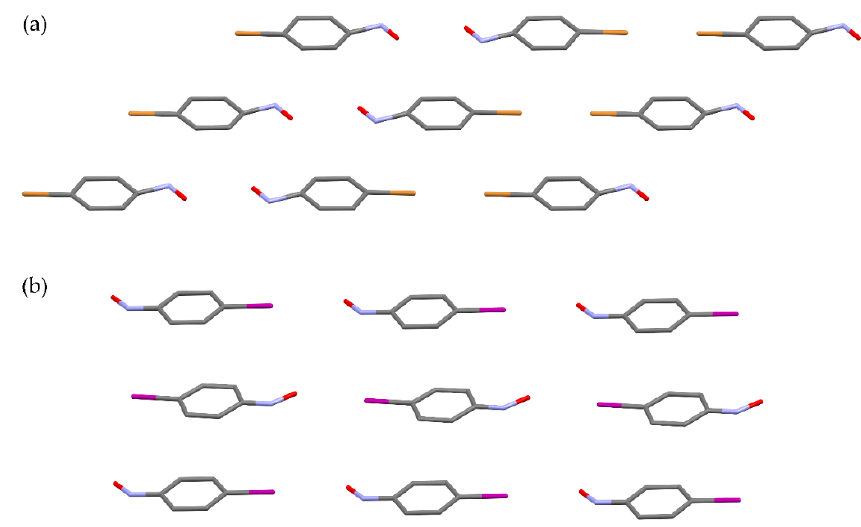
Figure 8. Crystal packing of the sublimed monomer of ( a ) p -bromo- [13] and ( b ) p -iodonitrosobenzene [60].